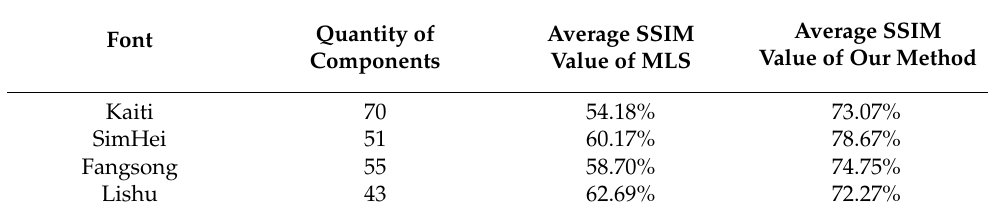
Table 6. Different fonts deformation data.